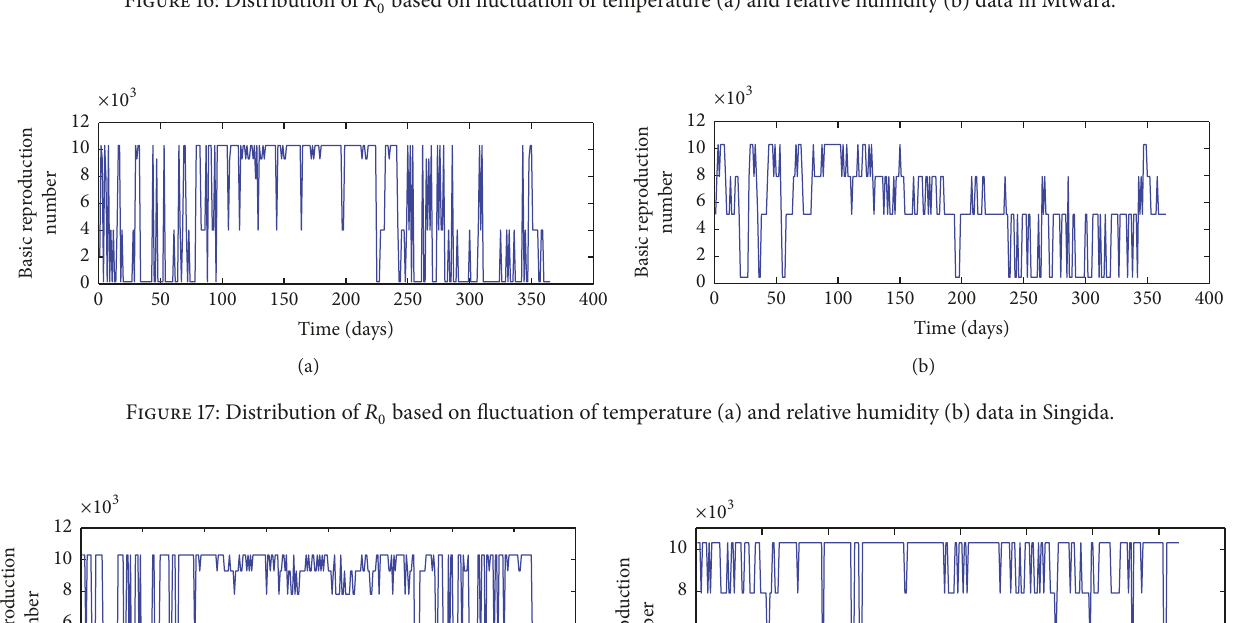
Figure 16: Distribution of 𝑅 0 based on fluctuation of temperature (a) and relative humidity (b) data in Mtwara.